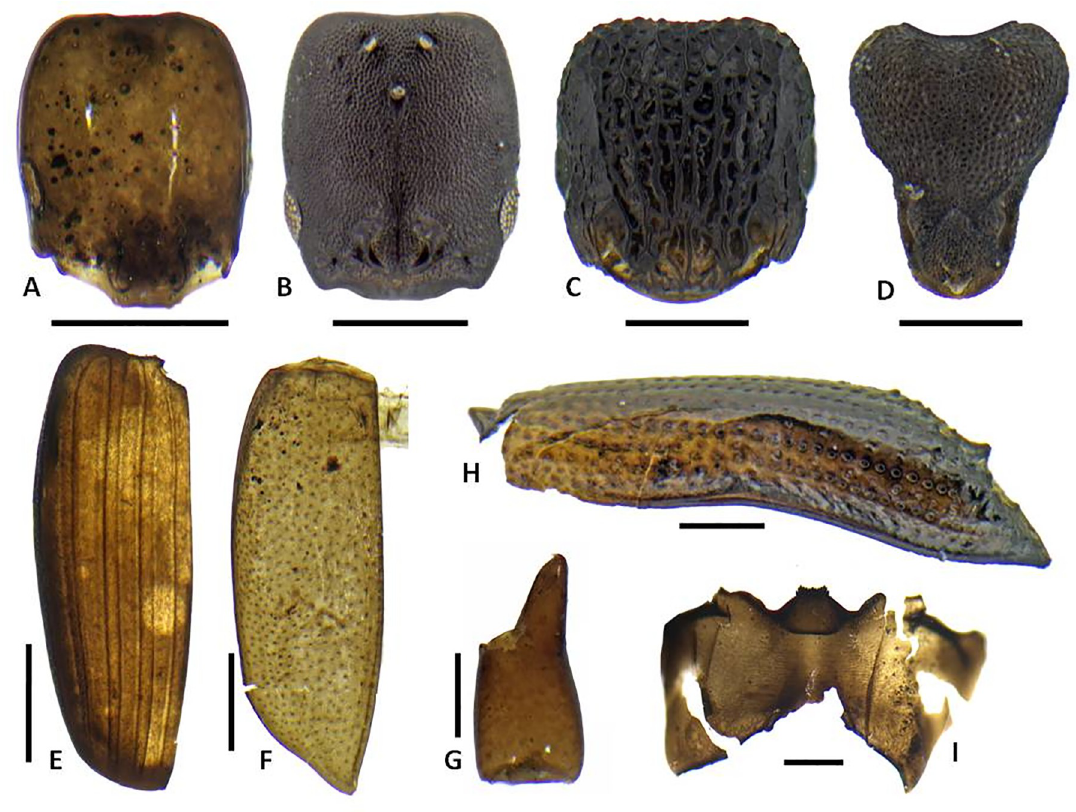
Fig 12. Representative insect subfossils of indigenous/endemic taxa 1. A. Monomorium sp. ant (Formicidae) head; B. Ponera cf . incerta queen ant (Formicidae) head; C. Tetramorium sp. 3 ‘new?’ ant (Formicidae) head; D. Strumigenys cf . mumfordi ant (Formicidae) head; E. Laemophloeidae beetle left elytron; F. Liodessus -type (Dytiscidae) beetle left elytron; G. Pseudoscorpion indet. chelicera; H. Xyleborini 1 (Curculionidae) weevil left elytron; I. Simulium (Diptera) larval head capsule. Scale bars all 0.25 mm. (Photo by N. Porch).